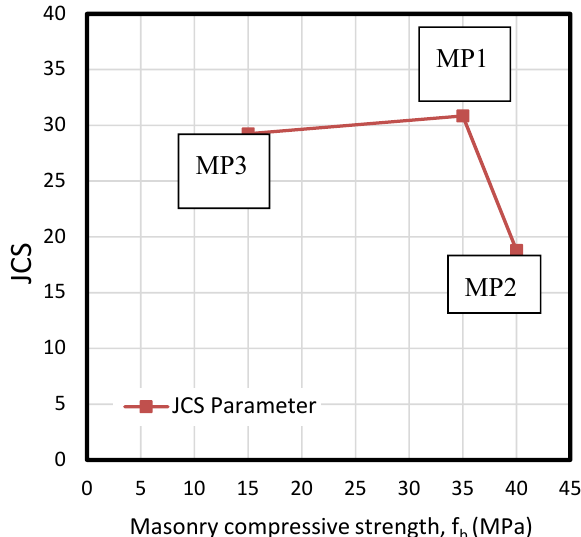
Figure 7. Calculated values of JCS depending on the compressive strength of tested masonry specimens